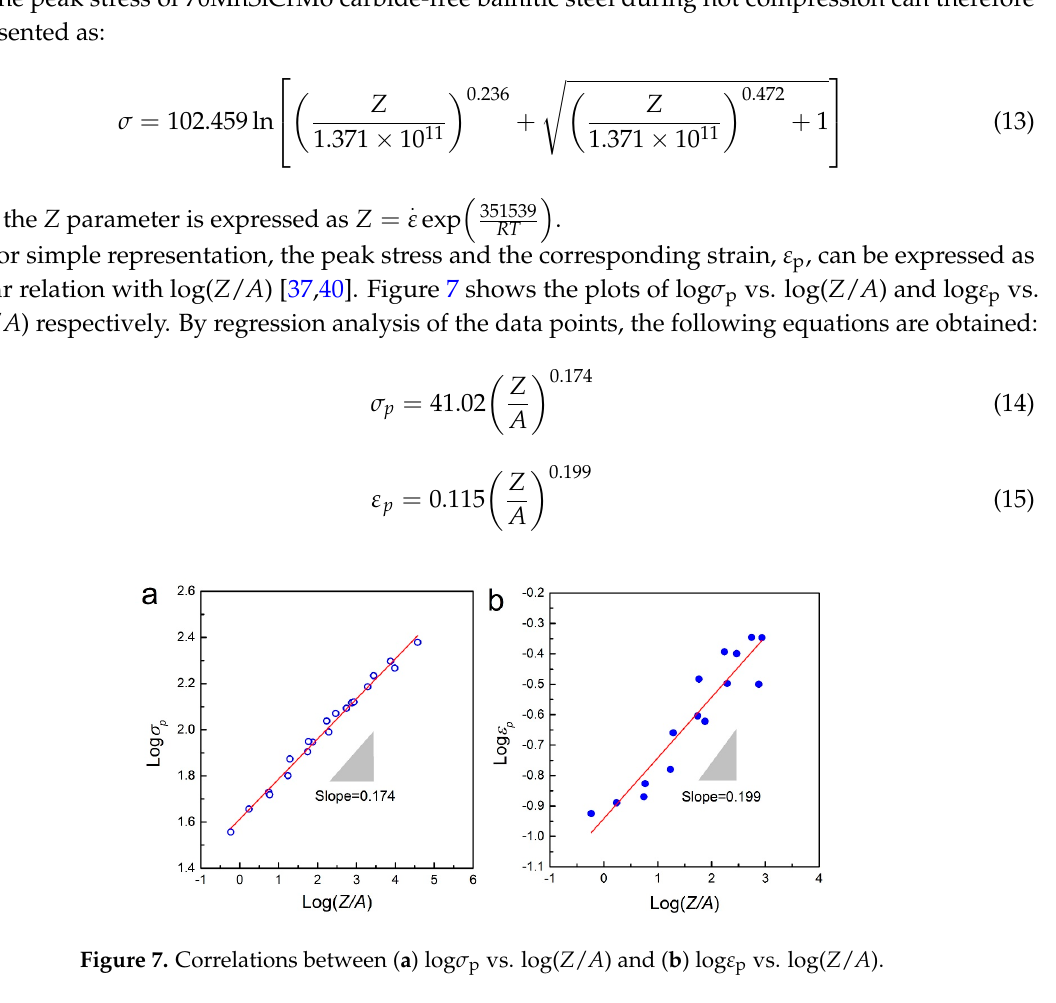
Figure 7. Correlations between ( a ) log σ p vs. log( Z / A ) and ( b ) log ε p vs. log( Z / A ).